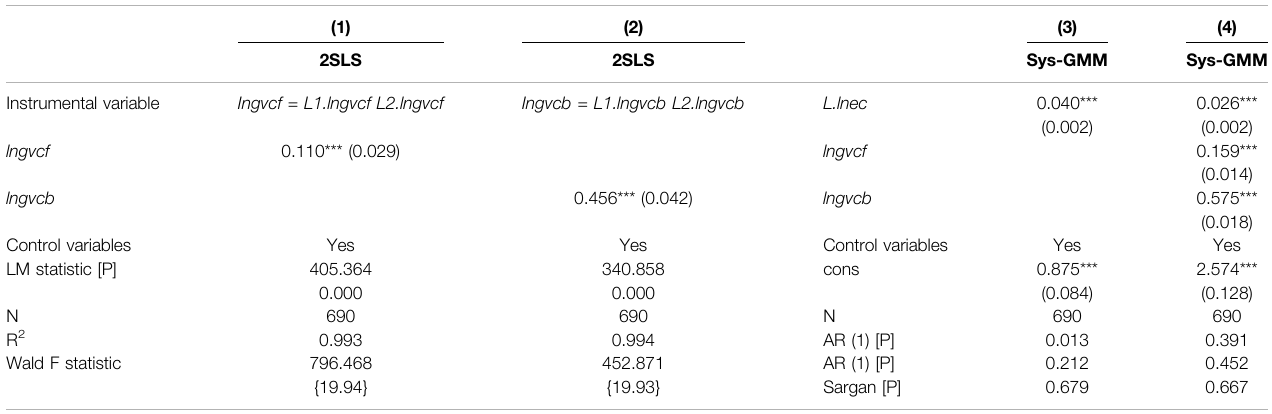
TABLE 4 | Endogeneity test results.